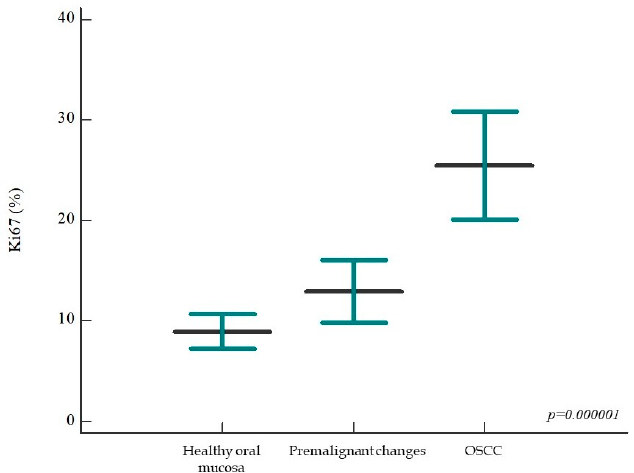
Figure 1 . Percentage of Ki-67 proliferation index between analyzed patient groups. The percentage of Ki-67 proliferation index is signi fi cantly higher in the group of patients with OSCC than in indi- viduals with healthy oral mucosa and premalignant changes ( p = 0.000001); no statistically signi fi - cant di ff erence was found between the la tt er two groups. Horizontal lines indicate mean ± standard deviation; p , signi fi cance level in graph ANOVA.